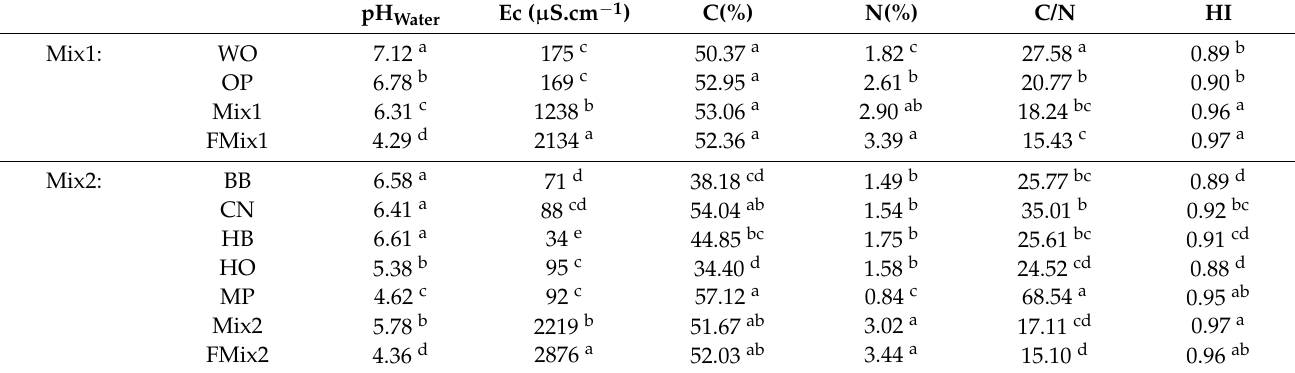
Table 1. Physico-chemical and chemical properties of the two mixtures (M1 and M2) of forest litters (WO: white oak, OP: holm oak and alepo pine, BB: bamboo, CN: chestnut, HB: hackberry, HO: holm oak, MP: maritime pine, Mix: mixture of litters before fermentation, FMix: mixture of litters after fermentation). Values are the mean of three replicates. Ec is the electric conductivity and HI the humification index. Different lowercase letters indicate significant ( p < 0.01) differences among